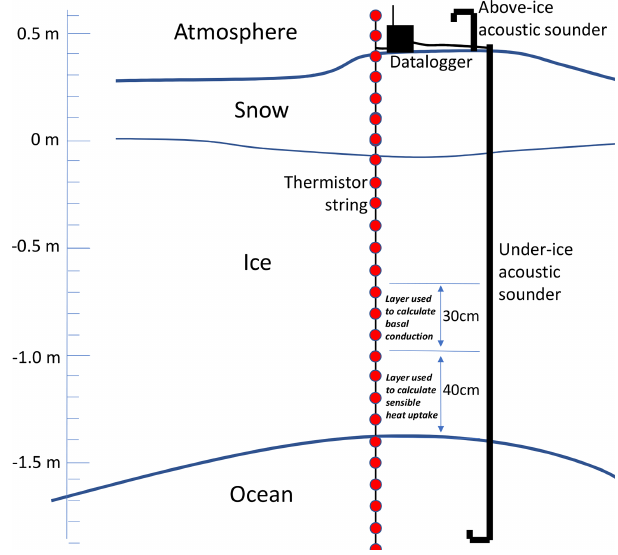
Figure 2. Diagram of the main components of an IMB, with layers used in this study for calculation of fluxes at the base of the ice indicated. Adapted from Fig. 1a of Planck et al.